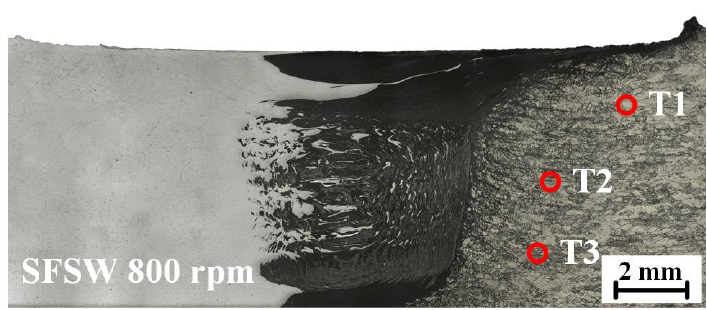
Figure 8. Diagram of the thermocouple position.